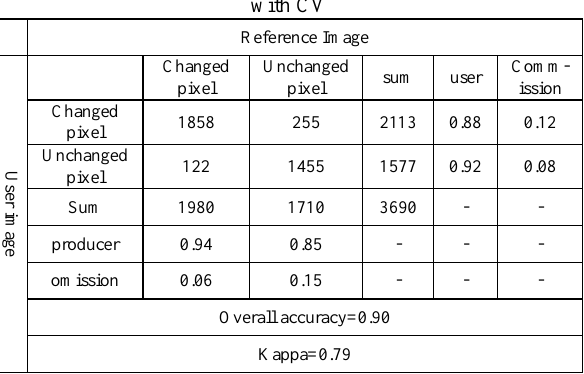
Figure 12. Change detection result of object-oriented method with CV